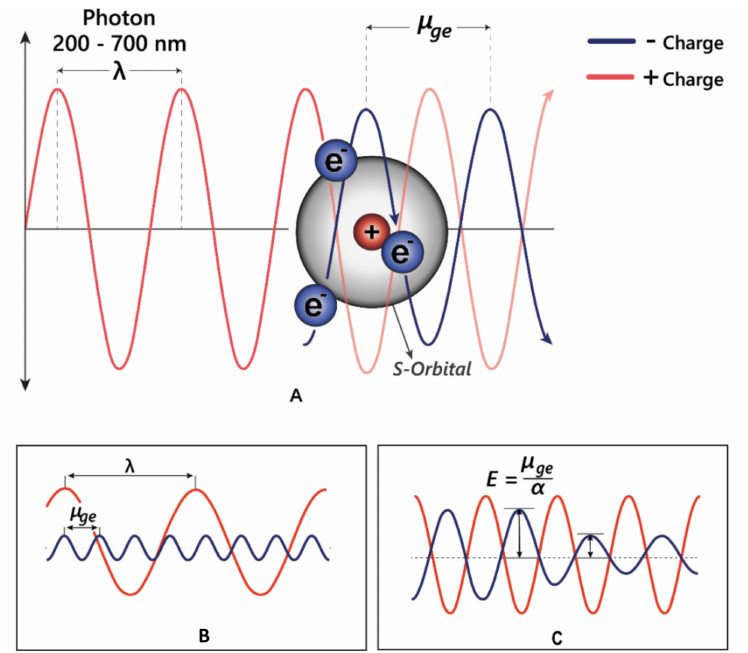
Figure 5. ( A ) Electrons can oscillate between the HOMO–LUMO by absorbing specific wavelengths of light. ( B ) The transition dipole moment ( µ ge ) is the difference between the energy in the ground state and the excited state. For promotion of an electron to a higher molecular orbital, µ ge = λ . ( C ) The strength of the interaction between electrons and electromagnetic radiation is dependent on the polarisation— α ; in highly polarised systems such as the anthocyanins, the transition energy is reduced, allowing absorption of longer wavelength